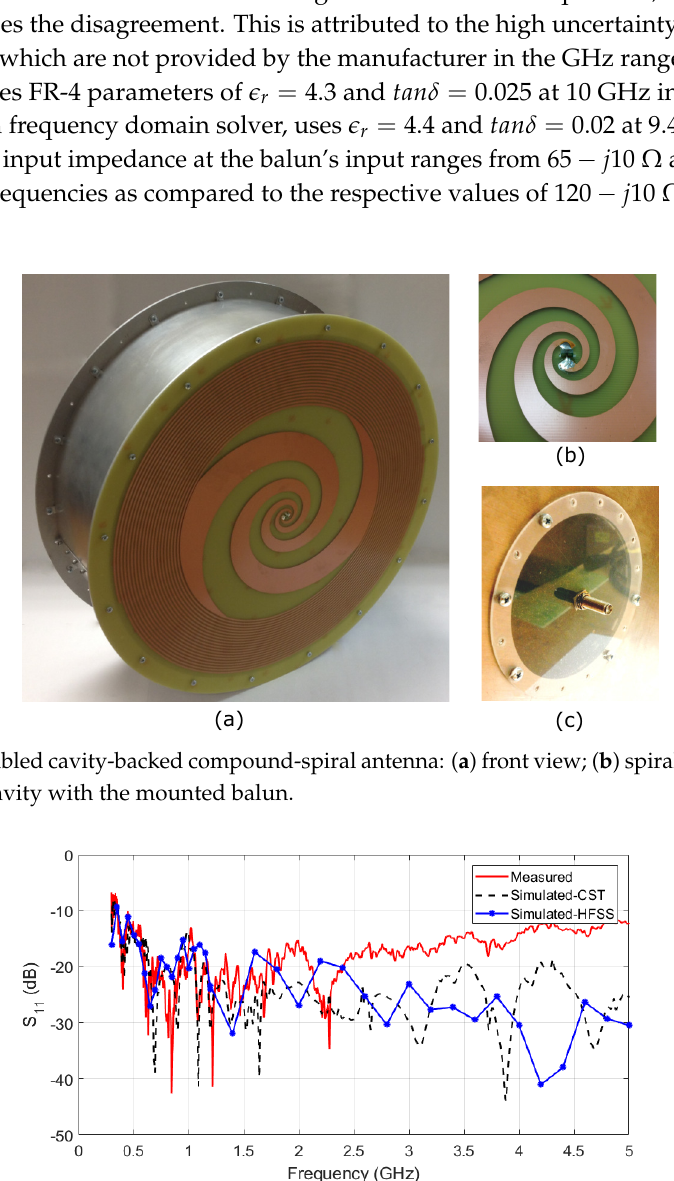
Figure 5. Measured and simulated reflection coefficient of the proposed